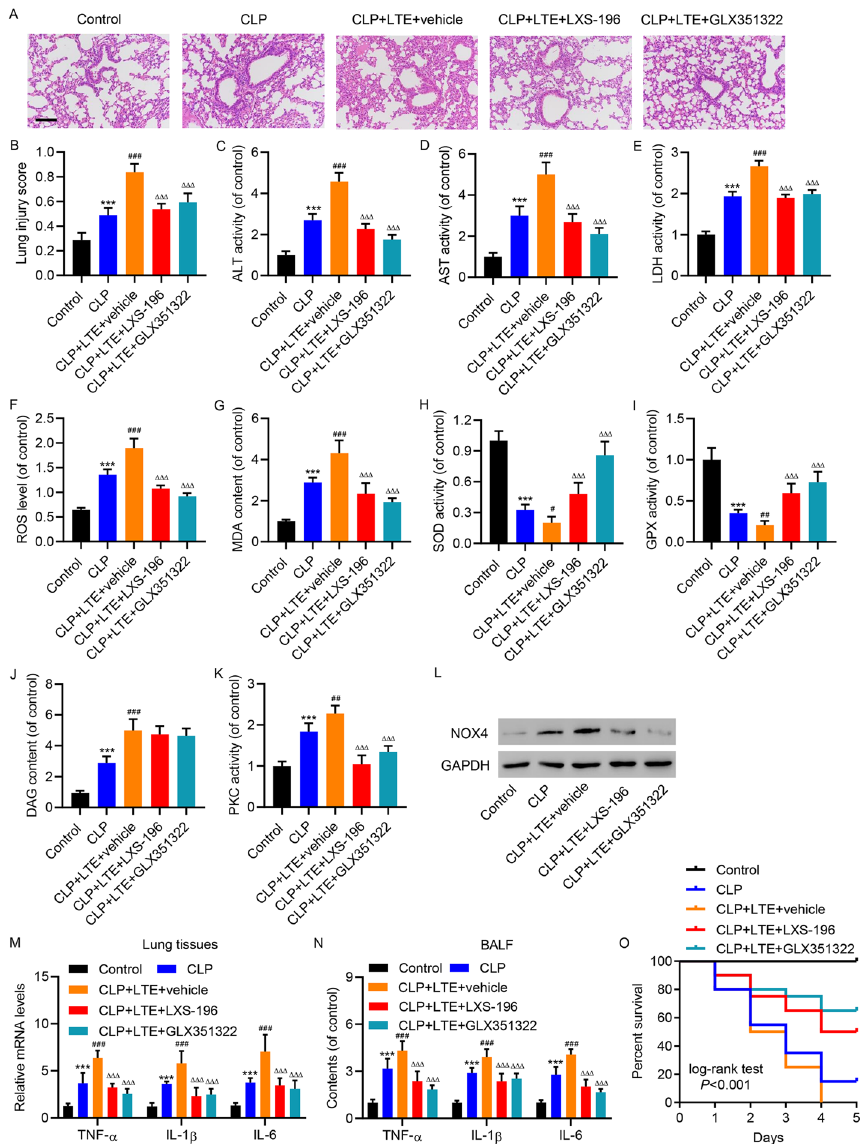
Fig. 5 Effects of T‑cell EVs on tissue damage, oxidative stress, and inflammation in mice with CLP‑induced lung injury were attenuated by PKC/NOX4 inhibition. Mice with CLP were stimulated with EVs isolated from CD4 + T cells isolated from healthy subjects treated with 10 μg/mL LPS (LTE), in the absence or presence of LXS‑196 or GLX351322. A H and E staining indicated that the severe lung injury by LTE treatment in CLP model mice was restored by LXS‑196 or GLX351322 (scale bar, 100 μm). B The severity of histological injury and plasma levels of ( C ) ALT, ( D ) AST, and ( E ) LDH by LTE treatment in CLP model mice was restored by LXS‑196 or GLX351322. The elevation of ( F ) ROS levels and ( G ) MDA content by LTE treatment in CLP model mice was restored by LXS‑196 or GLX351322. The reduction of ( H ) SOD and ( I ) GPX activities by LTE treatment in CLP model mice was restored by LXS‑196 and GLX351322. J The elevation of DAG content by LTE treatment in CLP model mice was not affected by LXS‑196 or GLX351322. K The elevation of PKC activity by LTE treatment in CLP model mice was restored by LXS‑196, but not GLX351322. L The elevation of NOX4 protein level by LTE treatment in CLP model mice was restored by LXS‑196 and GLX351322, as shown by western blot. M The elevation of mRNA expression of TNF‑α, IL‑1β, and IL‑6 by LTE treatment in CLP model mice was restored by LXS‑196 or GLX351322. N The elevation of BALF content of TNF‑α, IL‑1β, and IL‑6 by LTE treatment in CLP model mice was restored by LXS‑196 or GLX351322. O The shortened survival in CLP model mice treated with LTE was rescued by LXS‑196 and GLX351322. Data presented as mean SD. *** P < 0.001 ± versus control. # P < 0.05, ## P < 0.01, ### P < 0.001 versus CLP. ΔΔΔ P < 0.001 versus CLP LTE + +